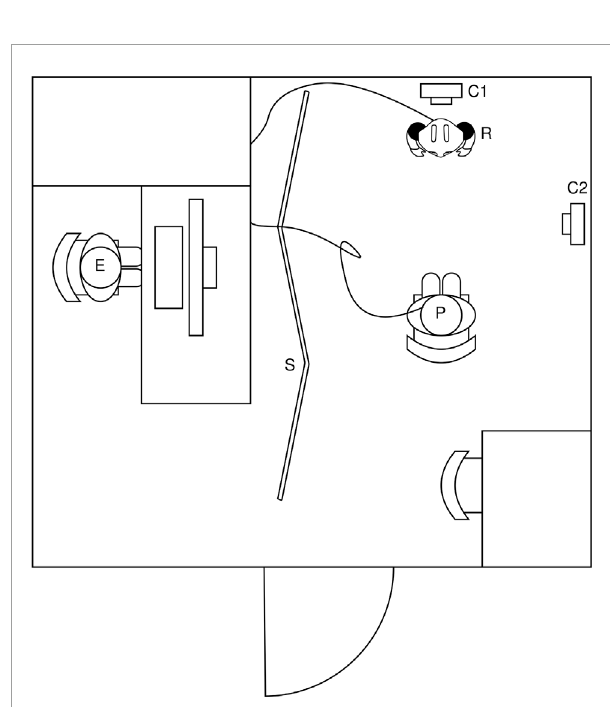
FIGURE 2 Schematic layout of the experiment room (4 m × 3.5 m).